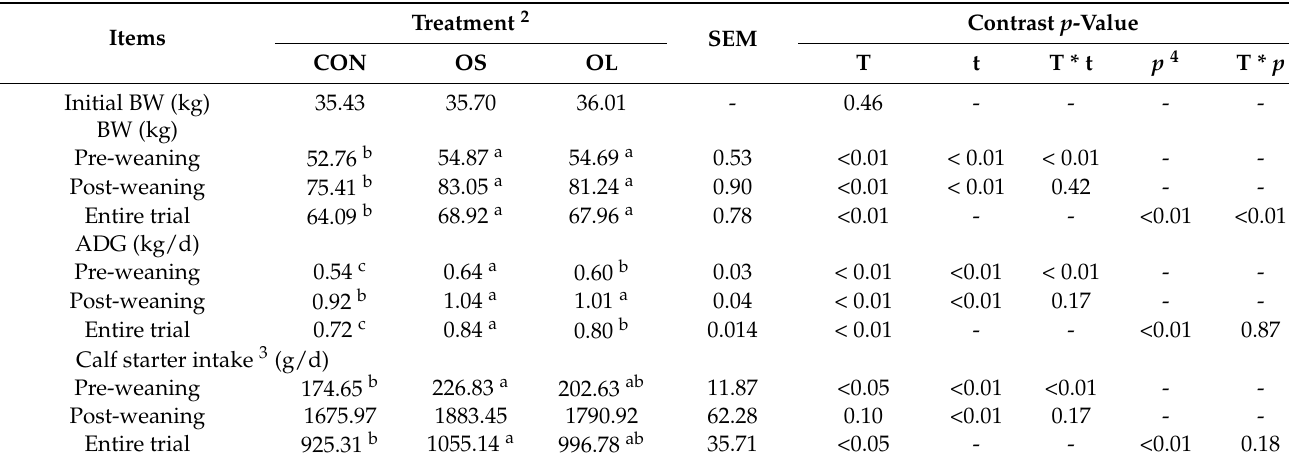
Table 1. Effects of different lengths of hay supplementation in Holstein dairy calves on BW, ADG, and calf starter intake in different periods of study 1 .